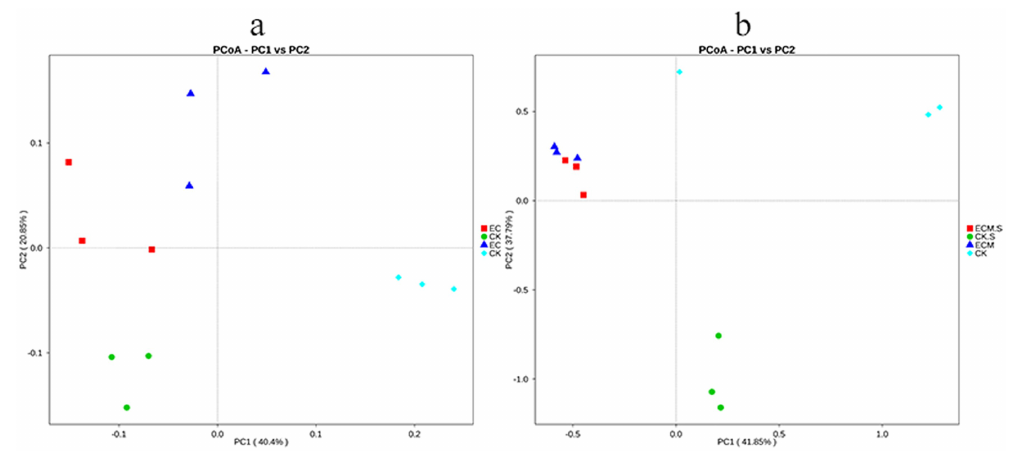
Fig 5. Principal Coordinate Analysis (PCoA) of bacterial (a) and fungal (b) communities associated with Pinus armandii roots and surrounding soils with or without Tuber indicum partner based on weighted UniFrac analysis. ECM and ECM.S, ectomycorrhizae ( Pinus armandii mycorrhized with Tuber indicum )and ectomycorrhizospheresoil. CK and CK.S, roots and soils from cultivated P . armandii without T . indicum partner.